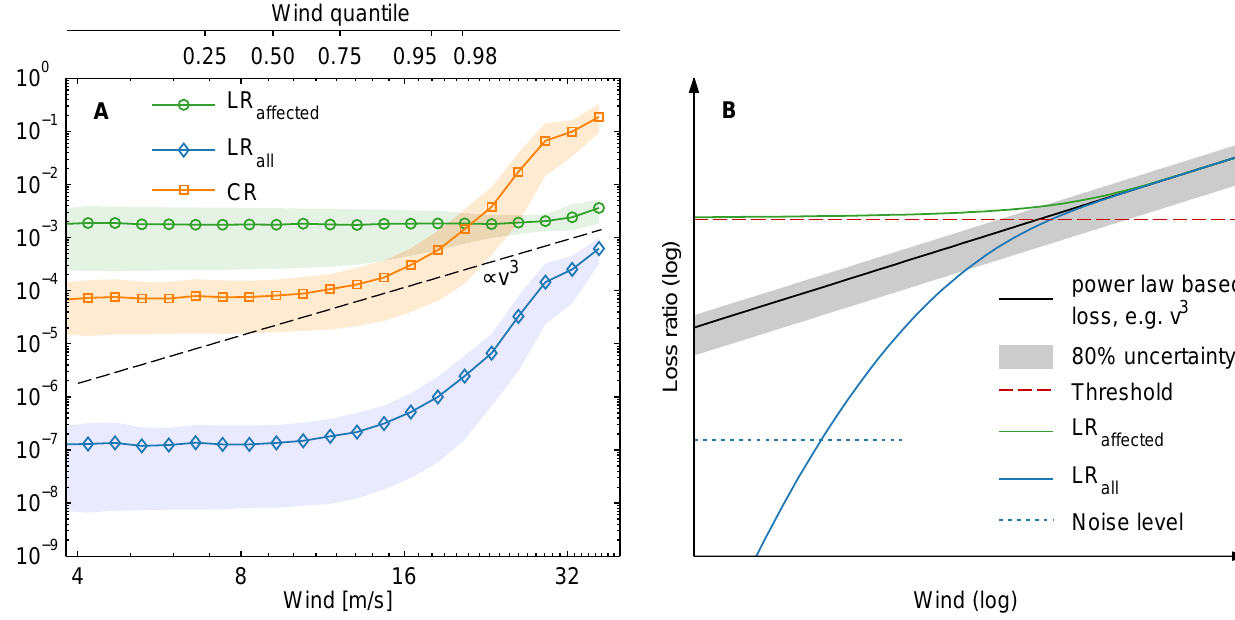
Figure 6. (a) shows the overall DWD gust dependence of the loss and claim ratio for all buildings and the loss ratio only of affected (i.e. damaged) buildings. Shown on a log–log scale, the solid curves represent expected values across all available districts and loss days, while the shaded areas indicate an 80% uncertainty interval for observations. The dashed line provides a guide to the eye representing a power laws with exponent 3. The upper scale indicates the respective wind gust quantiles. (b) shows schematically the decomposition of the loss ratio of a cubic loss–wind relationship subject to a minimum loss threshold. With a lognormal uncertainty distribution, indicated by the shaded 80% uncertainty bounds, a picture similar to (a)